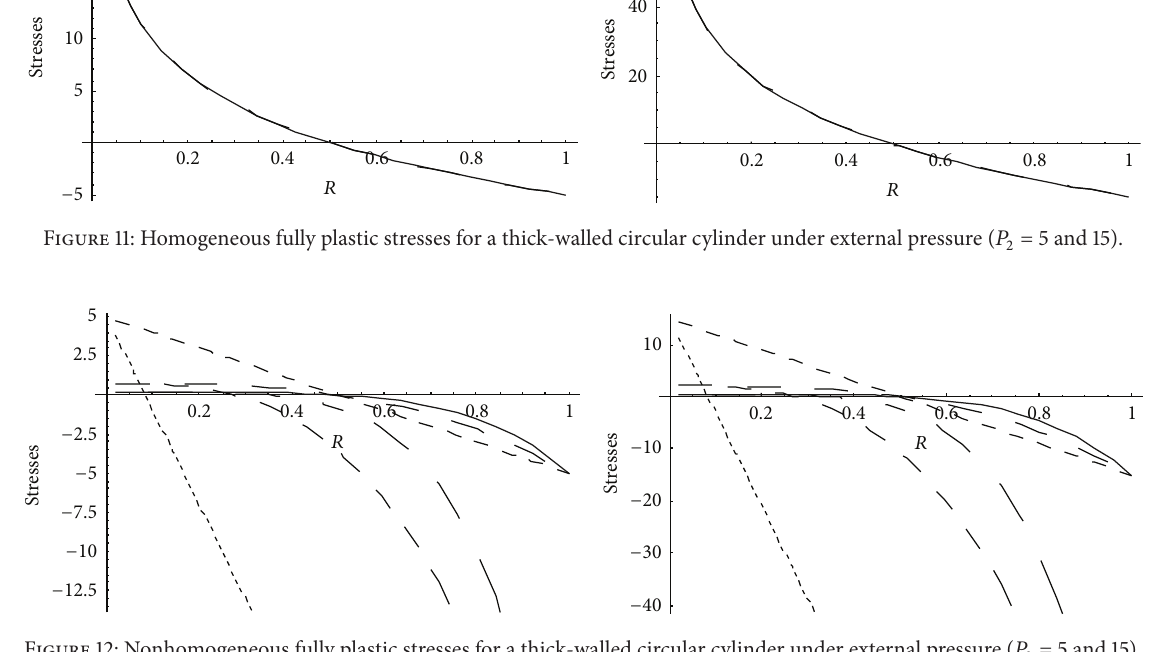
Figure 12: Nonhomogeneous fully plastic stresses for a thick-walled circular cylinder under external pressure ( 𝑃 2 = 5 and 15).